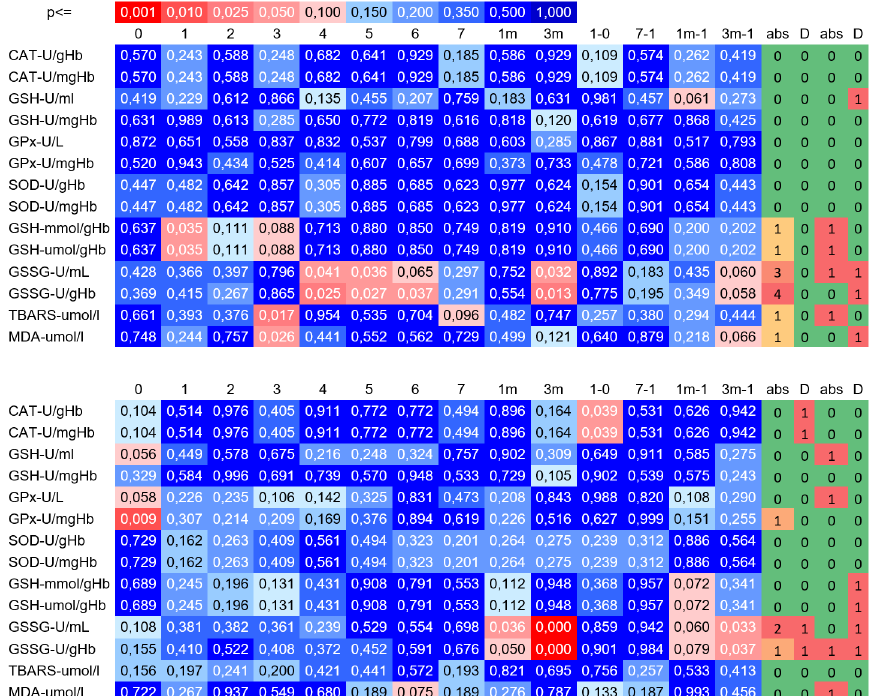
Figure A2. An example of a correlation matrix between oxidative stress biomarkers and one of blood count measured in the examined groups.